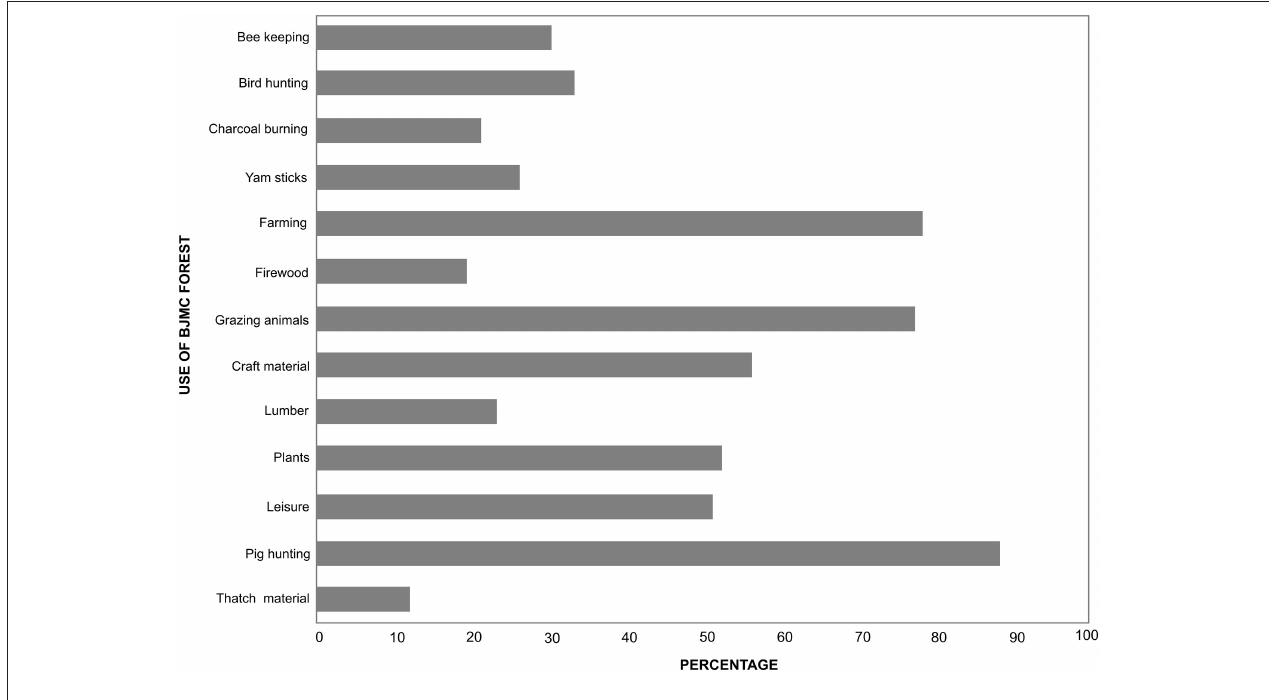
FIGURE 2 | Main provisional services of the BJCM reported by farmers.